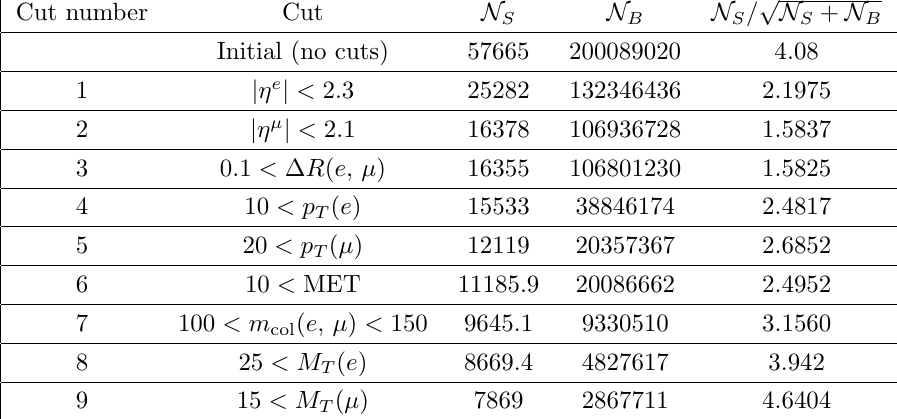
Table 2 . Kinematic cuts applied to the signal and main SM background for scenario SA , i.e, at HL-LHC with a center-of-mass energy p s = 14 TeV and